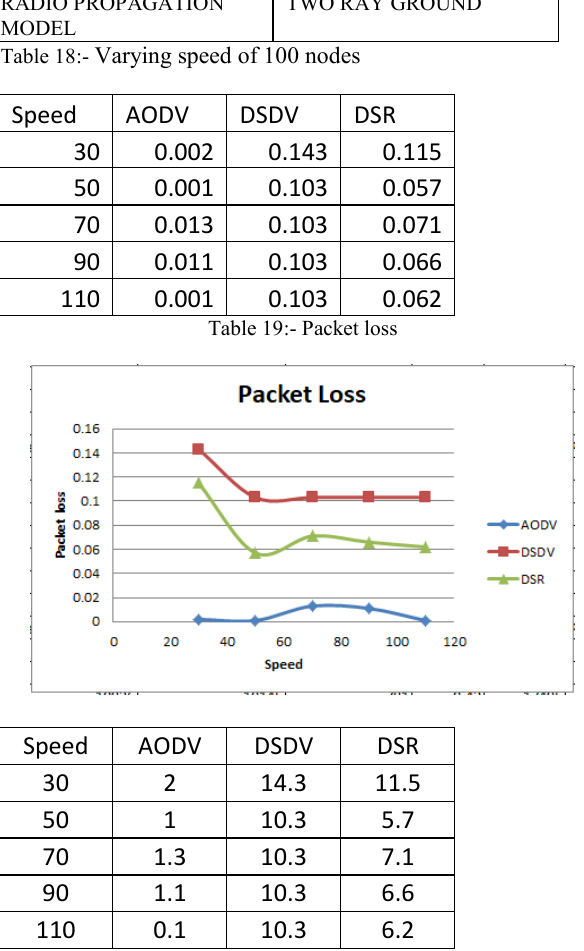
Table 20:- Packet loss ratio